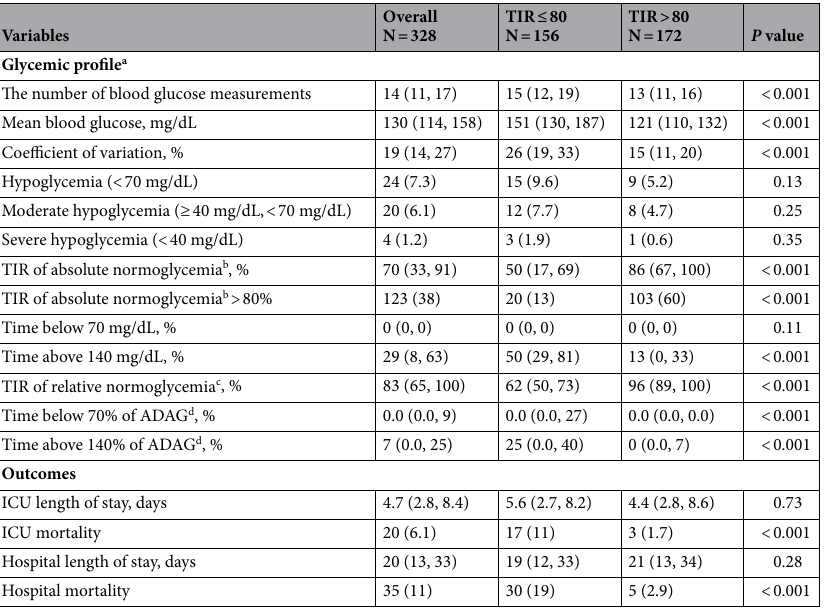
Table 2. Glycemic profile and outcomes: TIR of relative normoglycemia ≤ 80% vs. > 80% Data are expressed as median (interquartile range) or number (%). TIR time in range, ADAG A1C-derived average glucose. a During the first 72 h after ICU admission or ICU stay, whichever shorter. b Absolute normoglycemia was defined as measured blood glucose levels in the range of 70 to 140 mg/dL. c Relative normoglycemia was defined as measured blood glucose levels in the range of 70 to 140 of ADAG. d 1C-derived average glucose (mg/dL) can be obtained from the following formula: 28.7 × A1C (%) − 46.7.